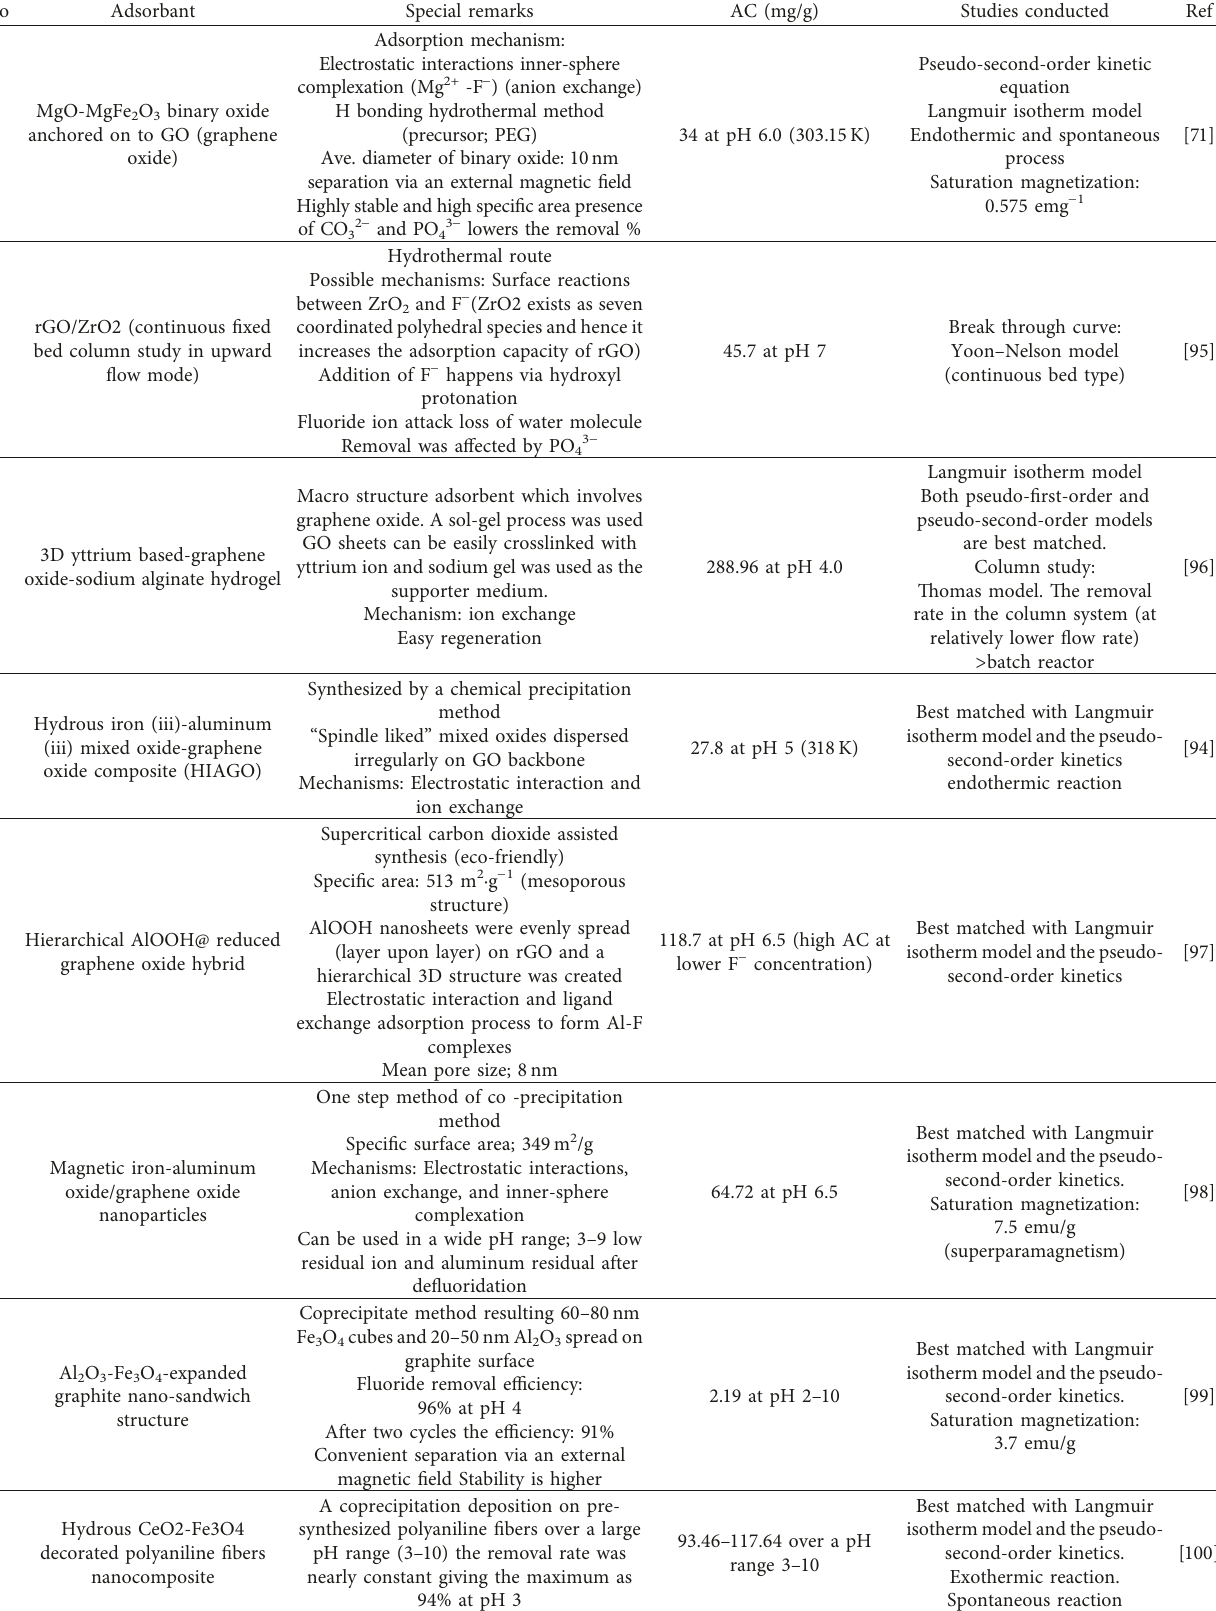
Table 1: Summary of fluoride removal capacities by different